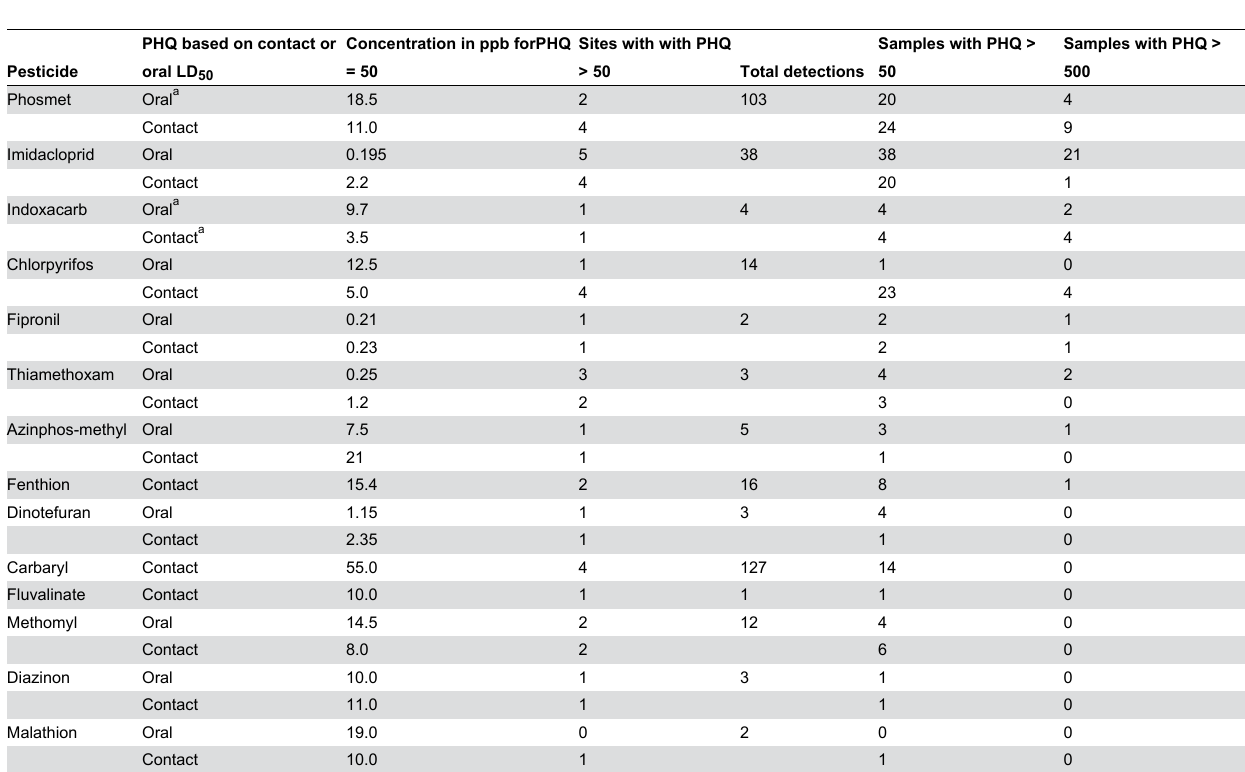
Table 4. The total number of sites (out of 5) and detections (out of a total of 313 samples analyzed from all sites and years) with residue concentrations for which HQ >50 using LD